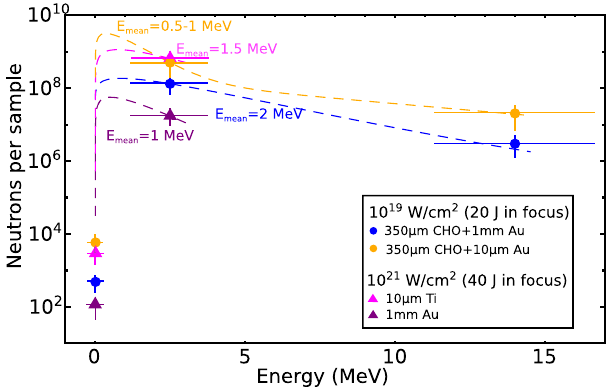
Fig. 6 Neutrons. Number of neutrons in different Giant Dipol Resonance (GDR) regions measured in the activation sample with 4.3 msr acceptance angle for different laser-target setups described in the legend. The error bars represent the accuracy of reaction yield and the width of nuclear resonance used for spectral reconstruction (see Methods). The mean neutron energies E mean are evaluated from the activation method (see methods) and used to build a Maxwellian-like energy distribution of neutrons